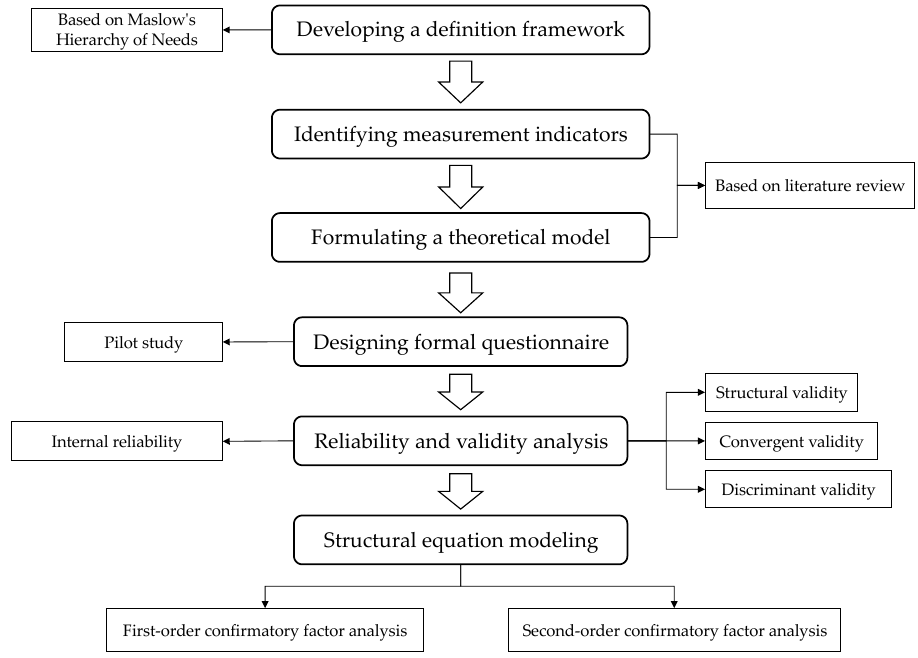
Figure 3. Research process of this study.